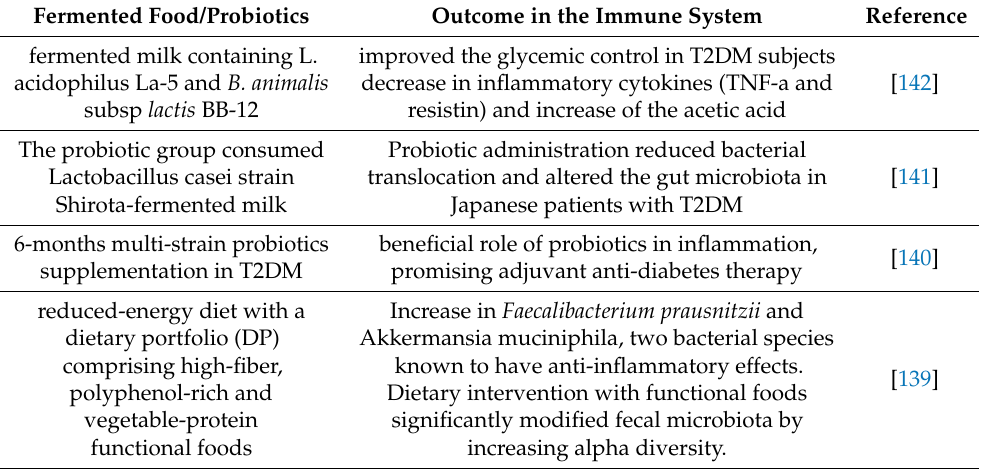
Table 2. Representative human studies showing supplementation with fermented foods containing probiotics, prebiotics and synbiotics and the main beneficial outcomes in the human body immune